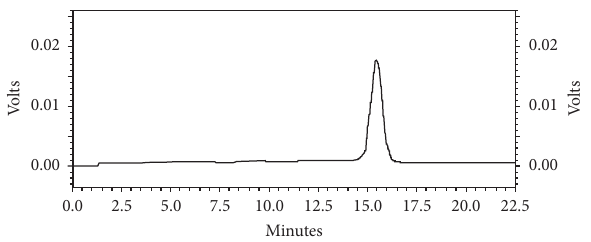
Figure 1: Identification of Huaier polysaccharide SP1 by high- performance liquid